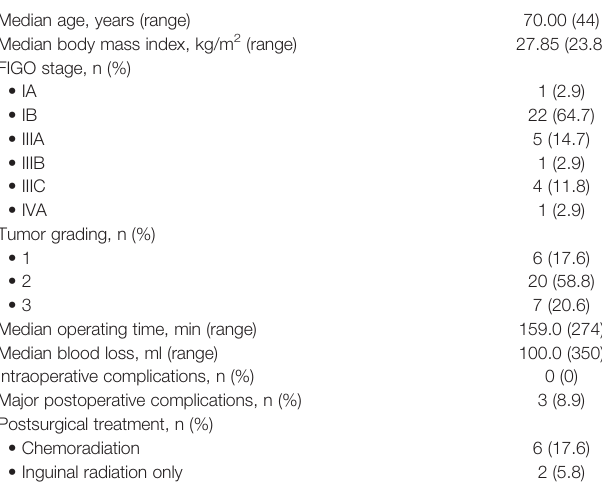
TABLE 1 | Patients ’ characteristics and operative data.